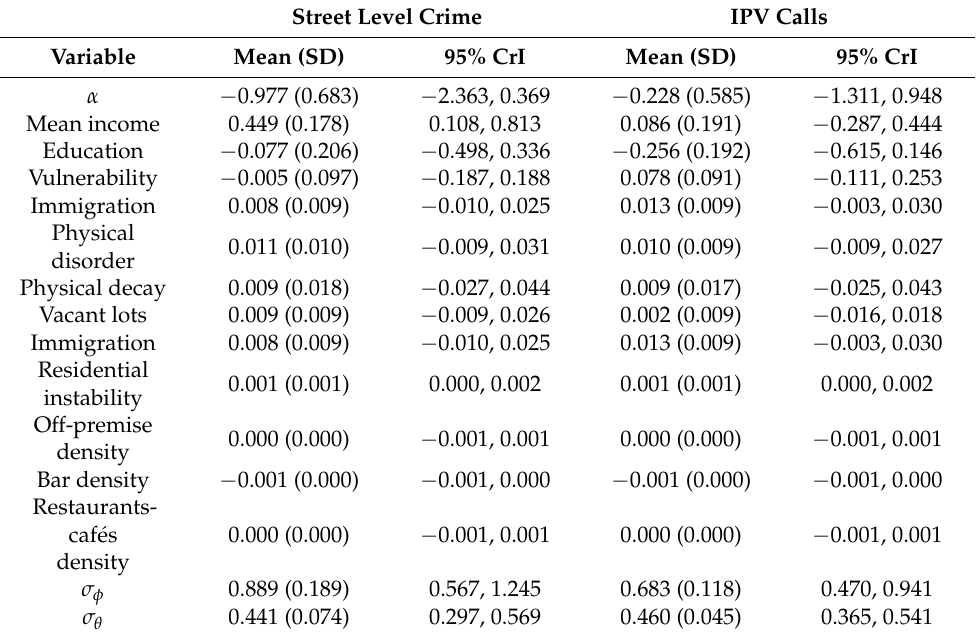
Table 3. Posterior distribution of the parameters of the spatial regression